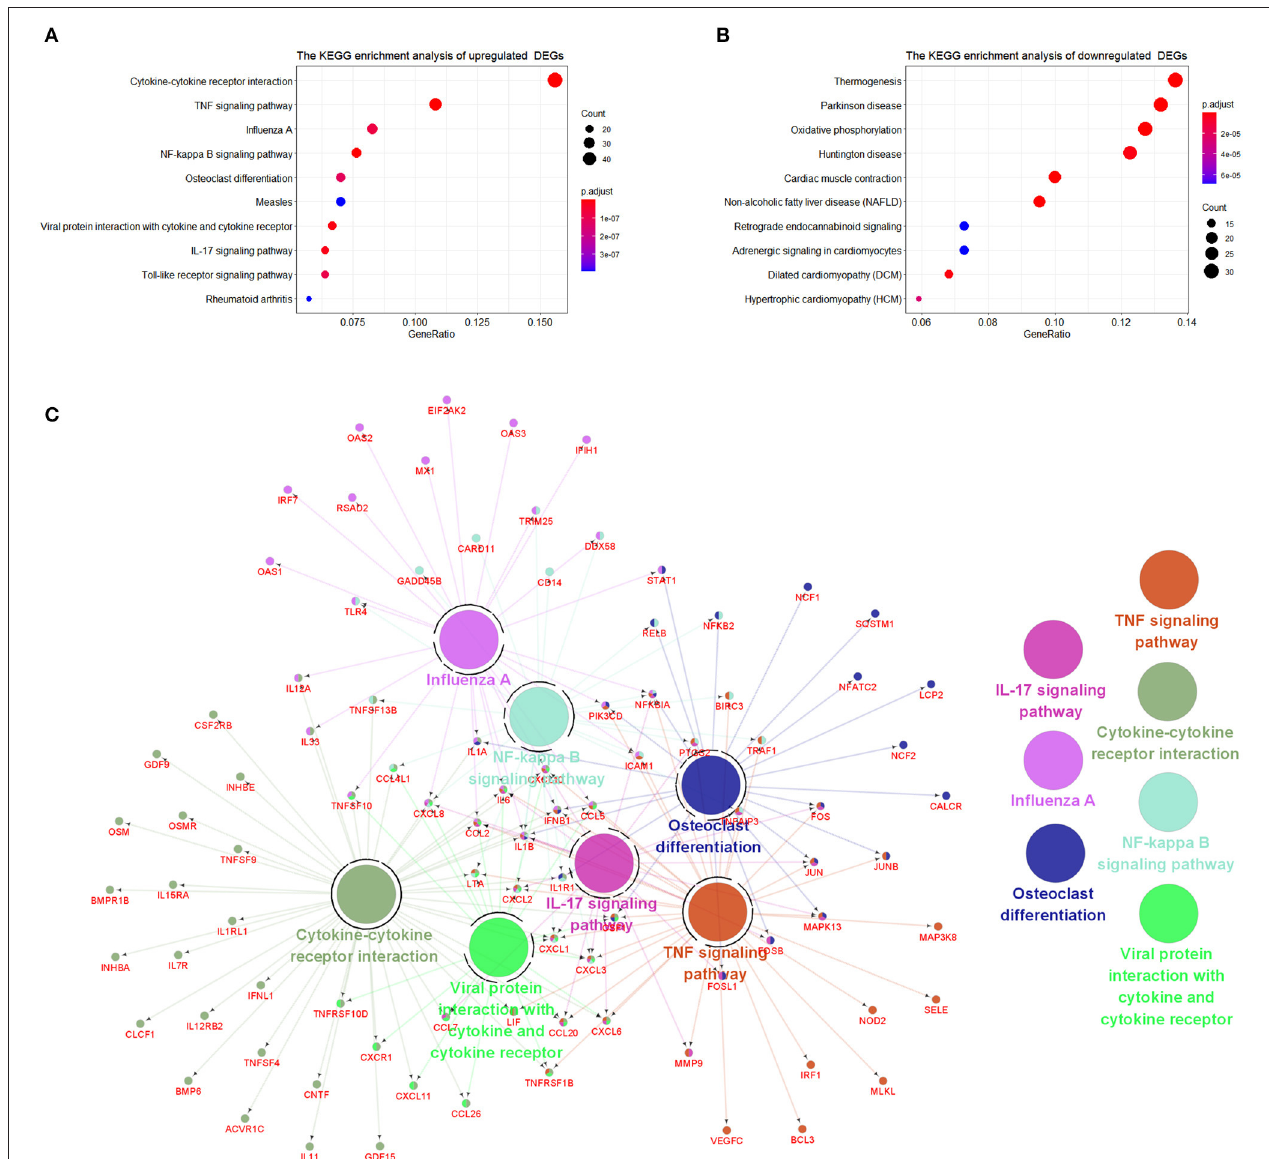
FIGURE 4 | The Kyoto encyclopedia of genes and genomes (KEGG) enrichment analysis of DEGs. (A) KEGG pathways of upregulated DEGs. (B) KEGG pathways of downregulated DEGs. (C) Representative pathways to genes network of upregulated DEGs validated genes (in red) targeted by KEGG